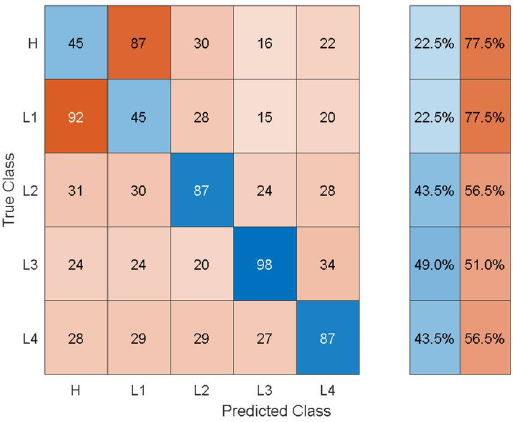
Figure 6. Training/validation confusion matrix of cubic SVM using handcrafted statistical features from simulated data.